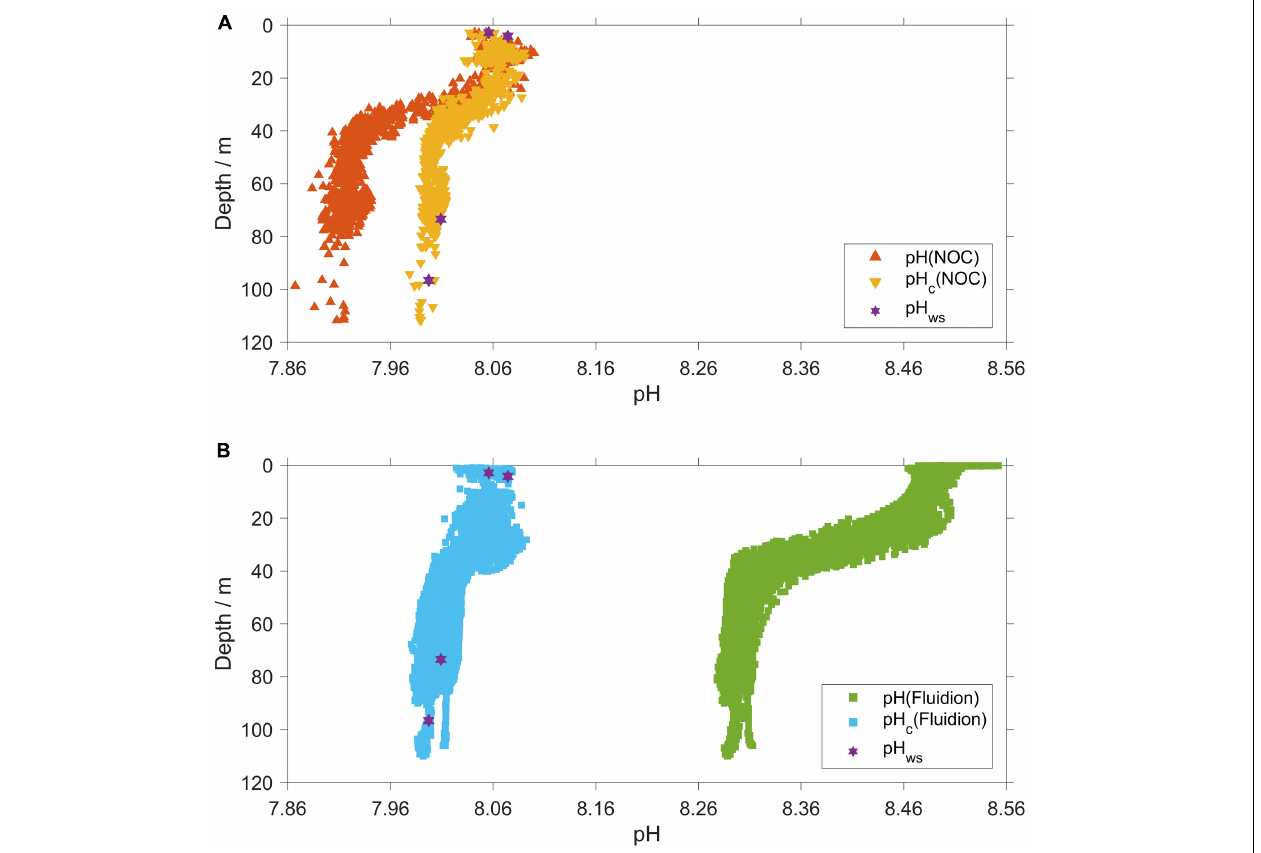
FIGURE 5 | (A) NOC pH corrections. Red triangles: uncorrected, pH(NOC); yellow triangles: delay- and temperature corrected (Eq. 1), pH c (NOC). (B) Fluidion pH corrections. Green squares: uncorrected, pH(Fluidion); azure squares: temperature and pH calibrated using Eq. 3, pH c (Fluidion). Violet stars: discrete samples collected at glider deployment and recovery, pH ws .